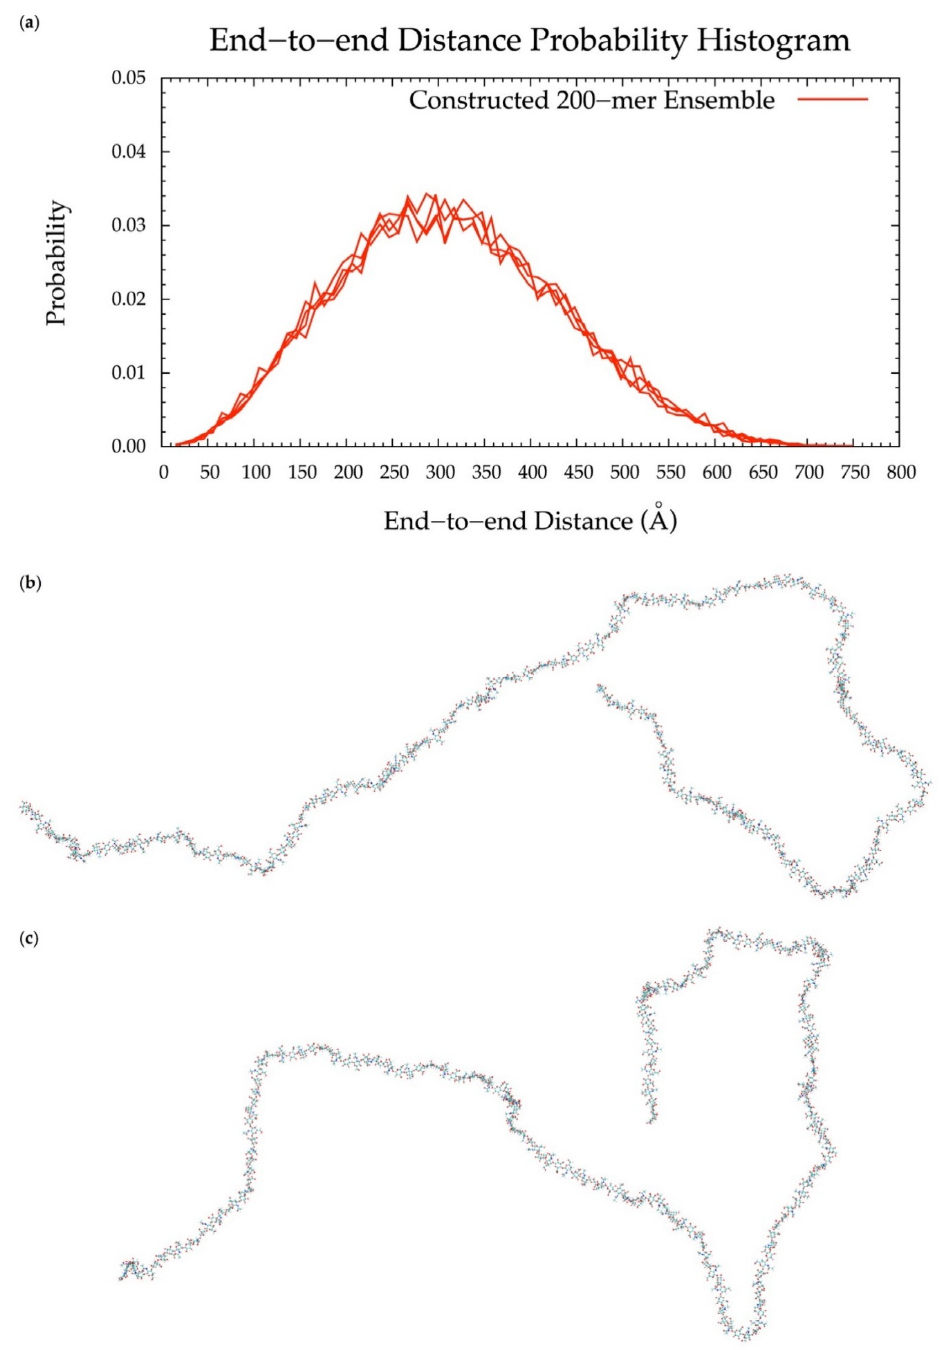
Figure 12. ( a ) End ‐ to ‐ end distance probability distribution of constructed 200 ‐ mer ensemble; includes four sets of 10,000 conformations; probabilities were calculated for end ‐ to ‐ end distances sorted into Å bins. ( b , c ) Snapshots of the non-sulfated chondroitin 200-mer having the most-probable end-to-end 10 Å bins. ( b , c ) Snapshots of the non ‐ sulfated chondroitin 200 ‐ mer having the most ‐ probable end ‐ to ‐ distance (300 Å in both snapshots) from constructed end distance (300 Å in both snapshots) from constructed ensembles.